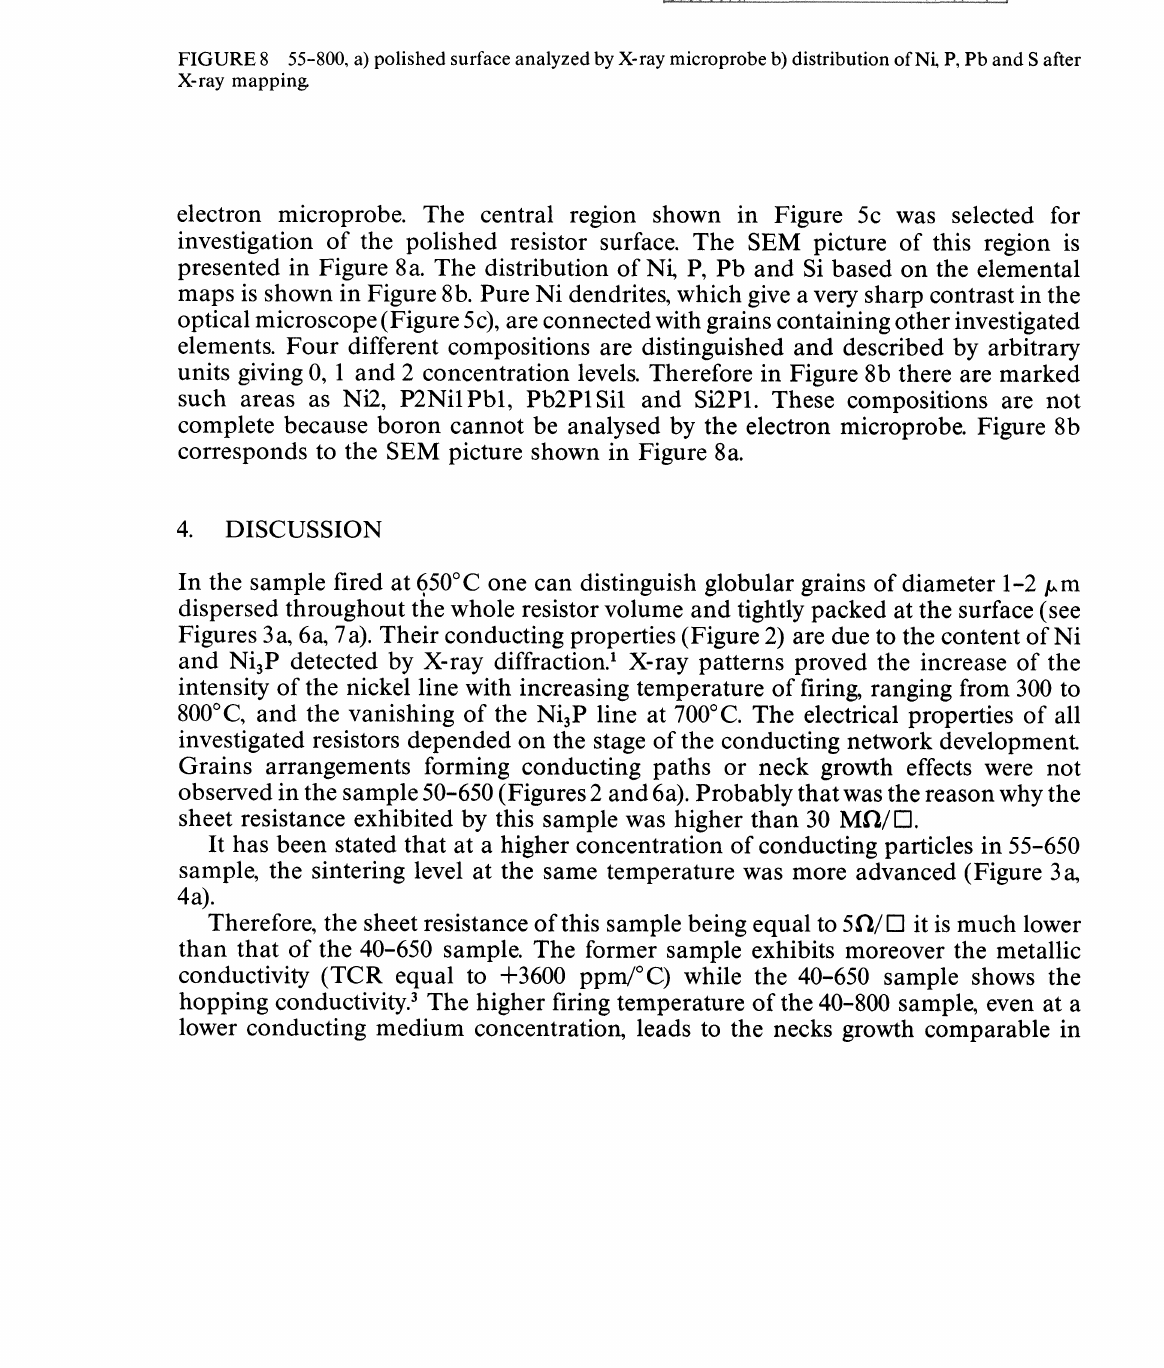
FIGURE 8 55-800, a) polished surface analyzed by X-ray microprobe b) distribution of Ni, P, Pb and S after X-ray